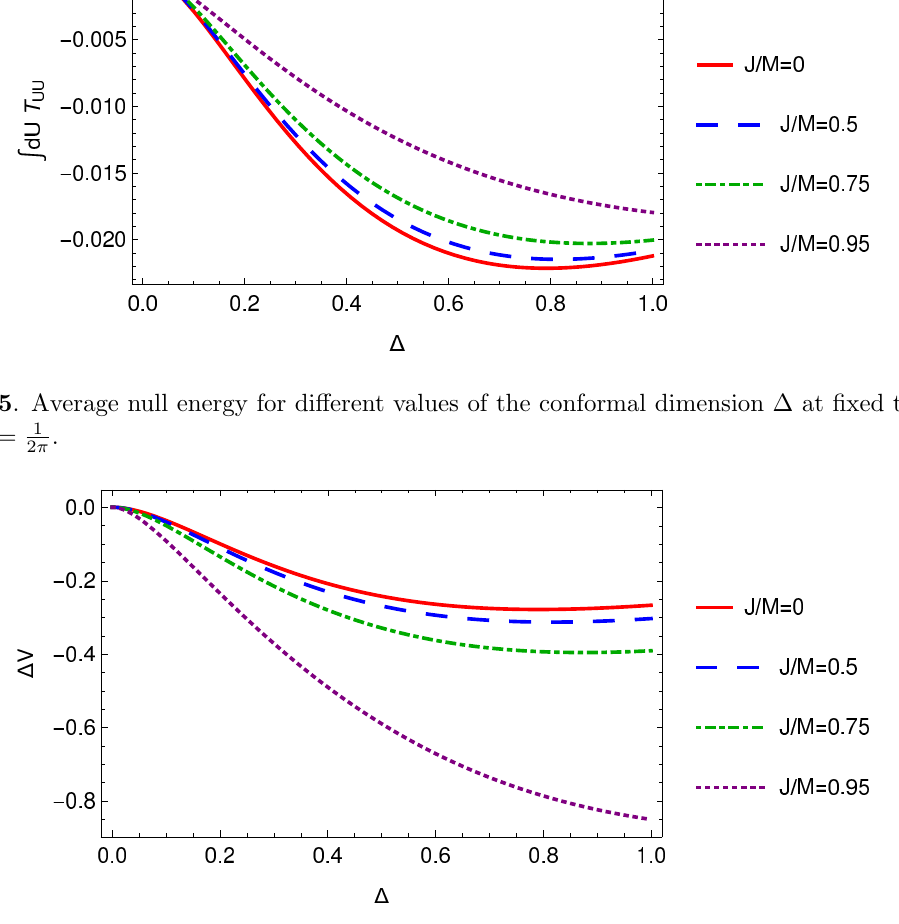
Figure 6 . Wormhole opening for di(cid:11)erent values of the conformal dimension (cid:1) at (cid:12)xed tempera- ture T = 1 2 (cid:25)